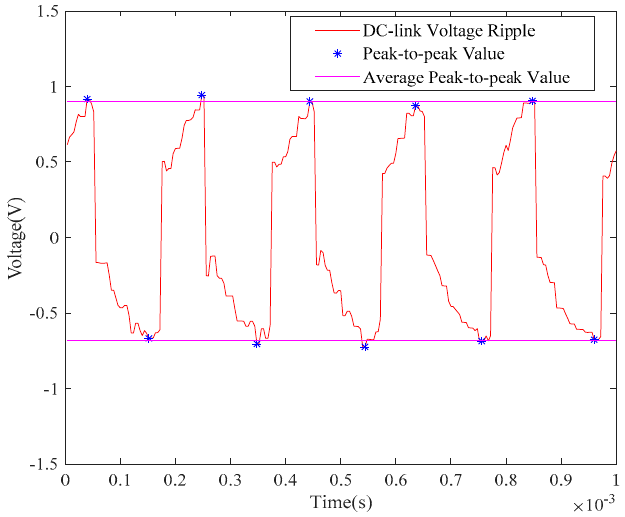
Figure 9. The peak-to-peak value of the required ripple voltage.